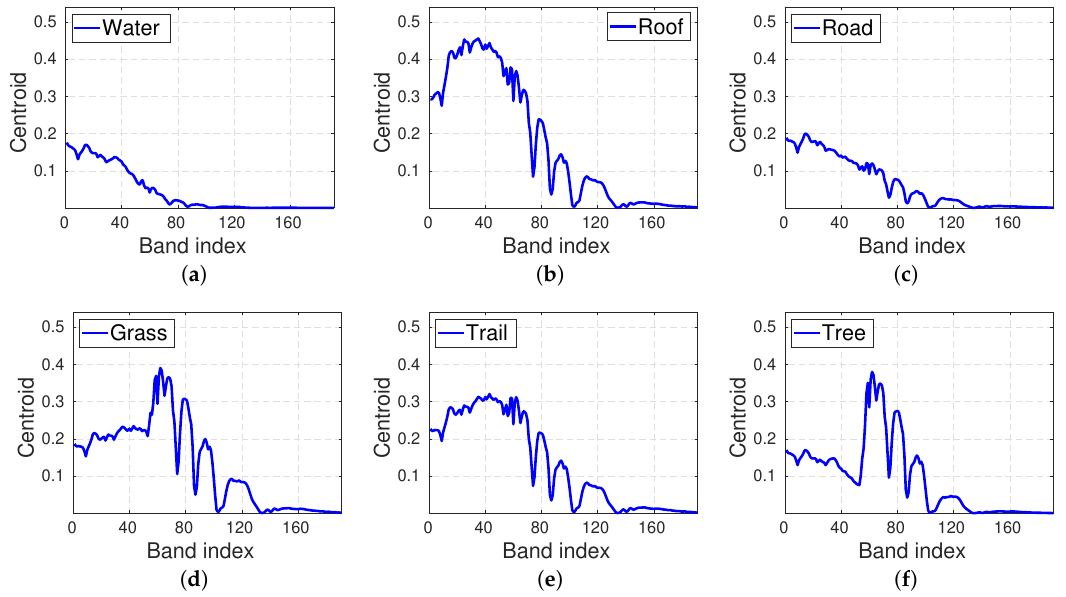
Figure 9. Cluster centroids of the partition of Washington DC with 6 endmembers: ( a ) centroid of Water; ( b ) centroid of Roof; ( c ) centroid of Road; ( d ) centroid of Grass; ( e ) centroid of Trail; ( f ) centroid of